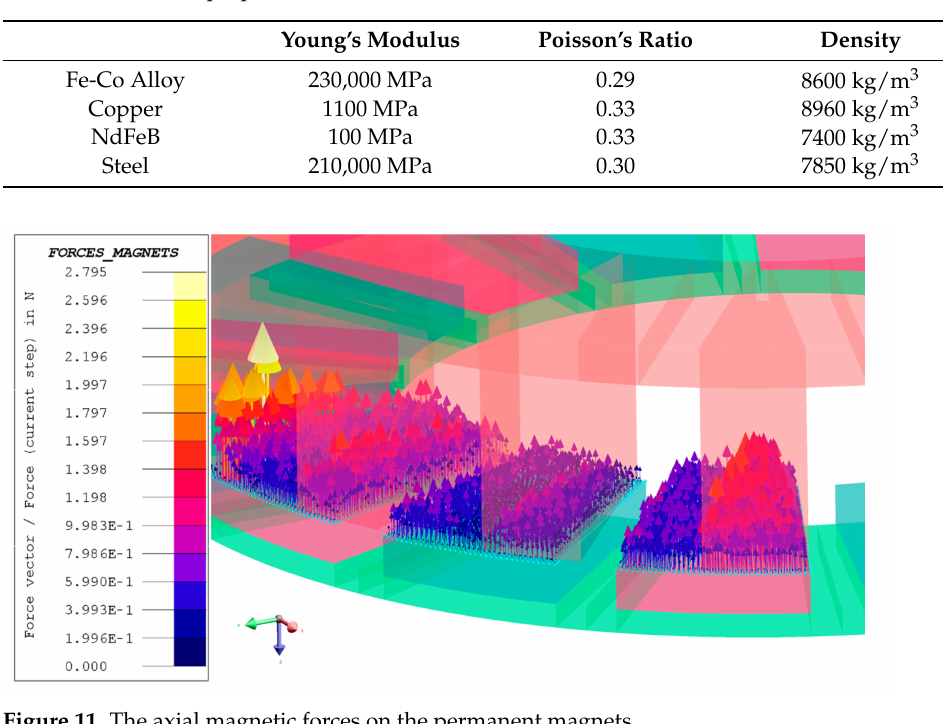
Figure 11. The axial magnetic forces on the permanent magnets.